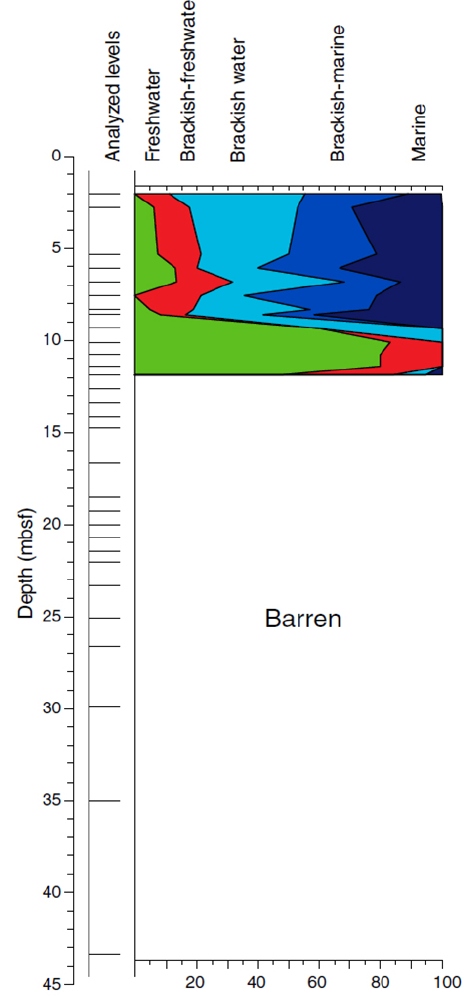
Figure 7. Bornholm Basin, site M0065. Relative distribution of di- atom taxa according to their preferred habitat